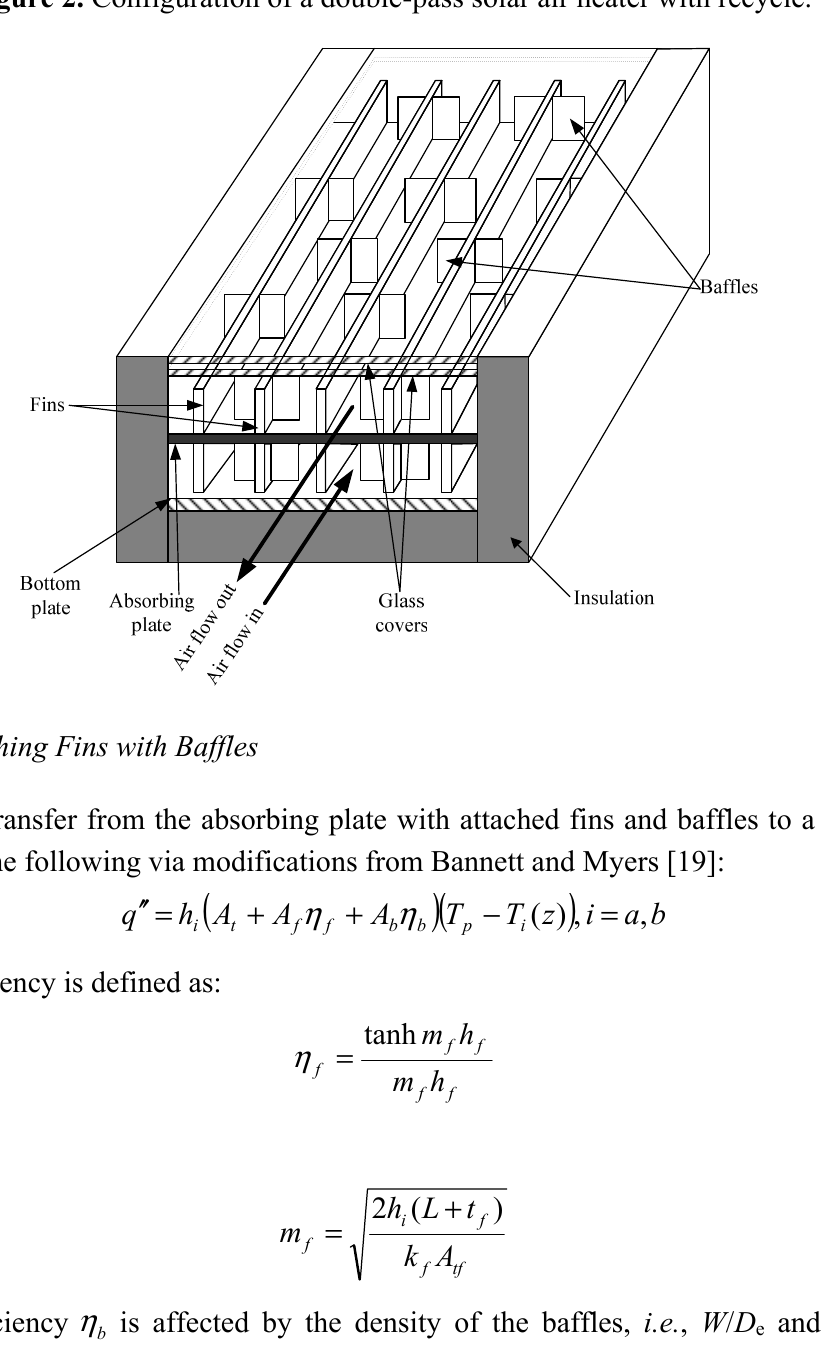
Figure 2. Configuration of a double-pass solar air heater with